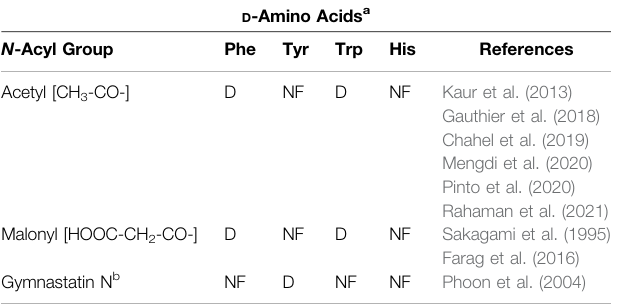
TABLE 2 | N -Acyl-D-Aromatic Amino Acids Identi fi ed from Living Systems D -Amino Acids a